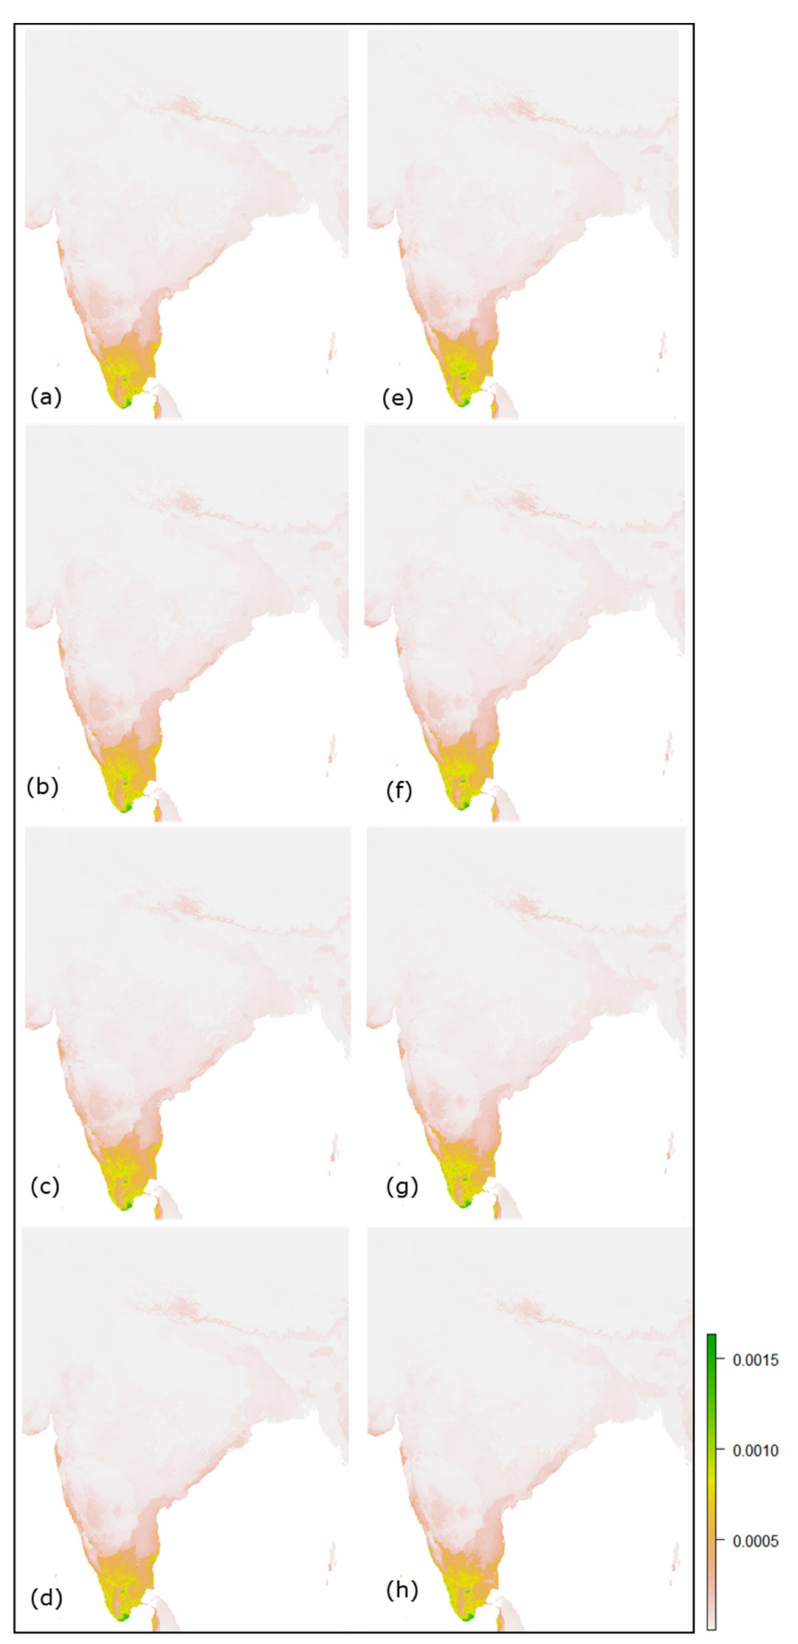
Figure 12. Predicted future suitability maps for January-May in India: ( a – d ) and ( e – h ) represent the SSPs 2.6, 4.5, 7.0 and 8.5 for 2030 and 2050,